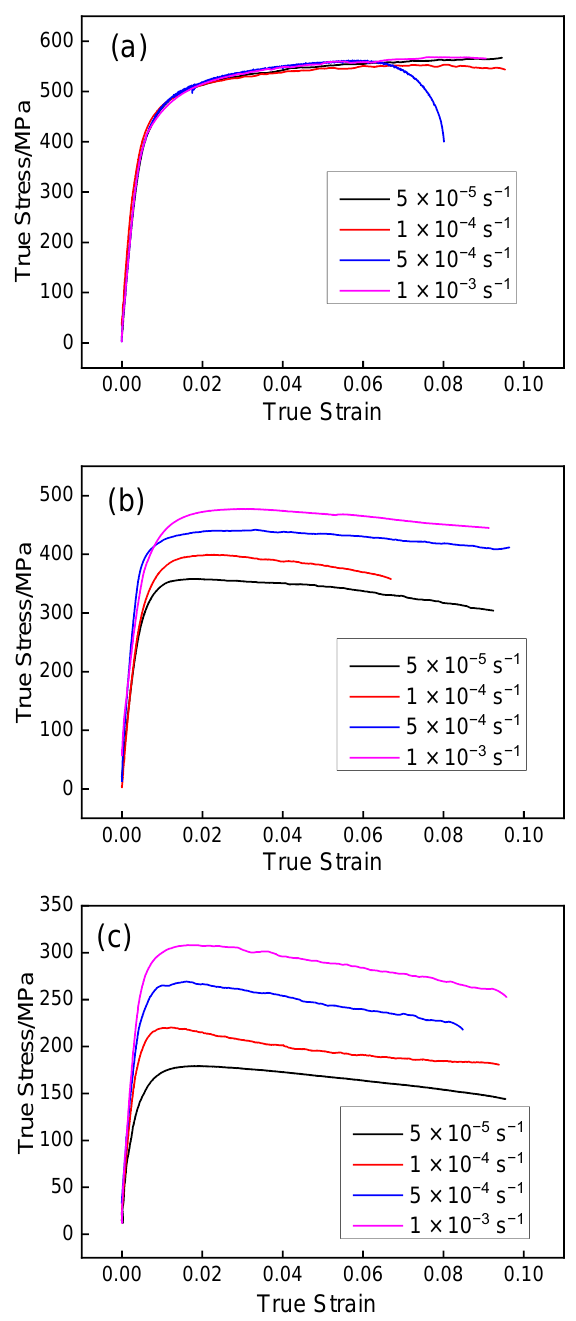
◦ C; ( b ) 600 ◦ C; ( c ) 700 ◦